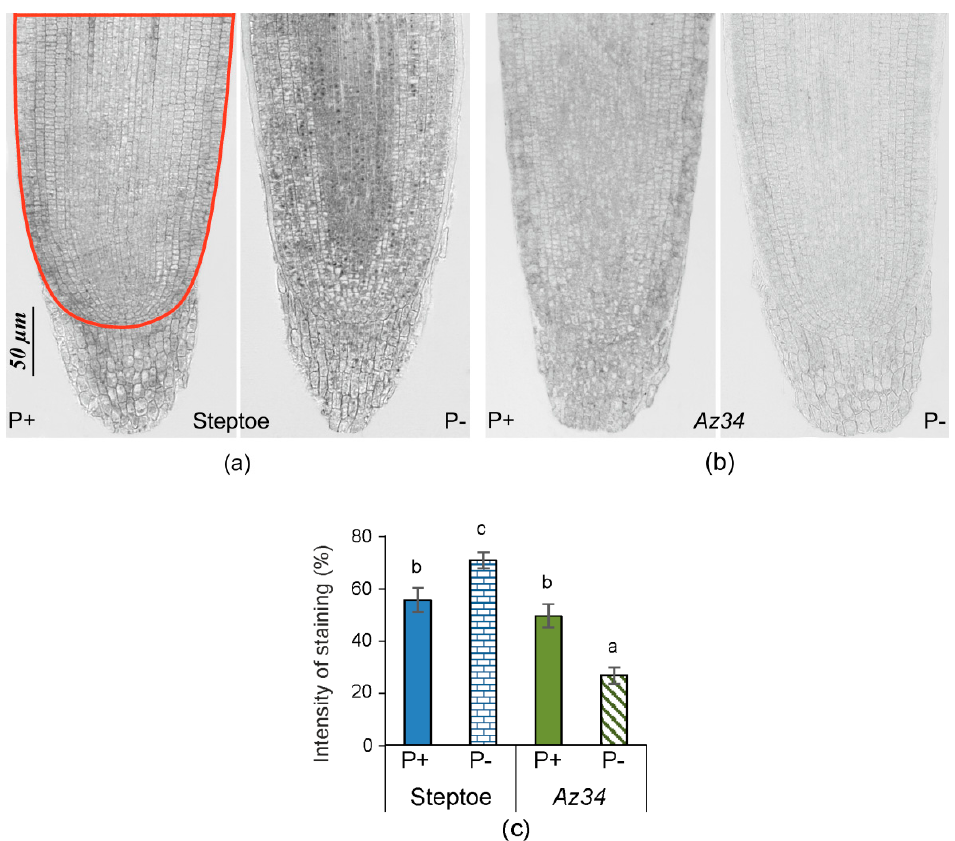
Figure 5. Immunolocalization of ABA in root tips of 4-days-old barley seedlings (cv. Steptoe ( a ) and Az34 ( b )) grown for 1 day on the nutrient solutions with (P+) or without (P − ) phosphate. Scale bars 50µm. The staining intensity on all sections was evaluated in the area marked with a colored line in